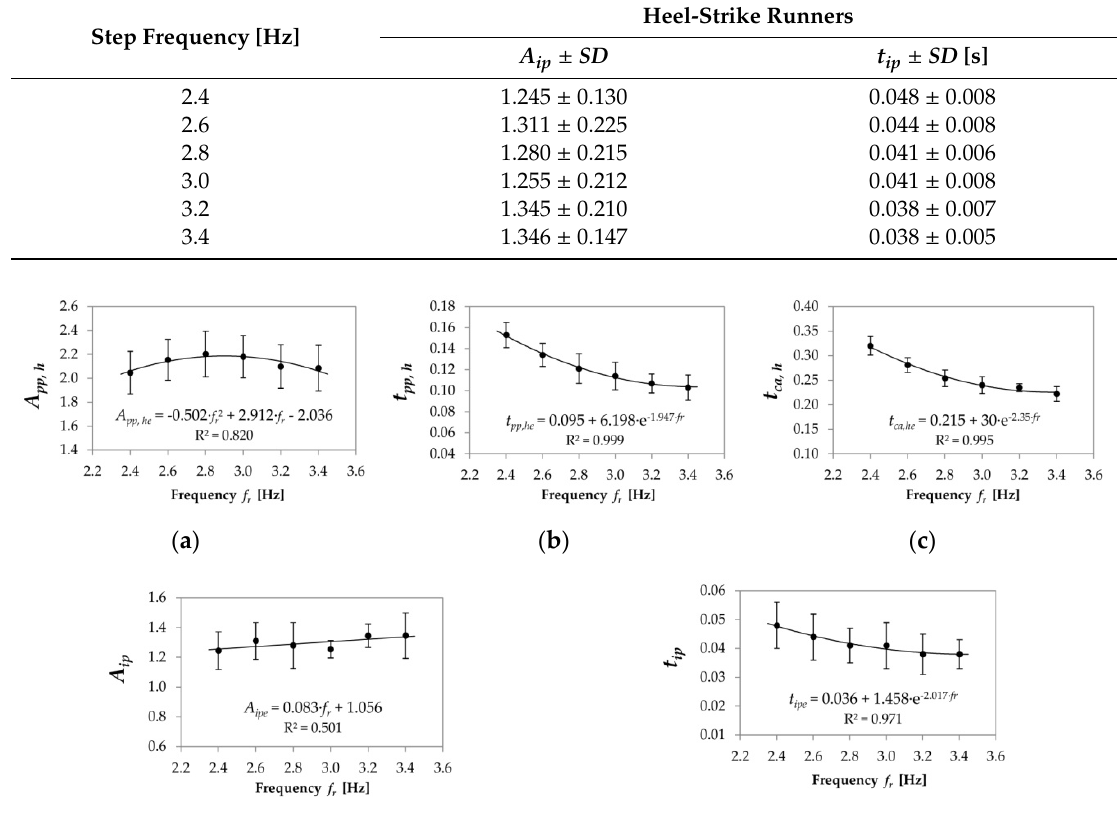
Figure 3. The F VGRF curve indicators for heel-strike running style:( a ) indicator A pp,h , ( b ) indicator t pp,h , ( c ) indicator t ca,h , ( d ) indicator A ip , ( e ) indicator t ip .